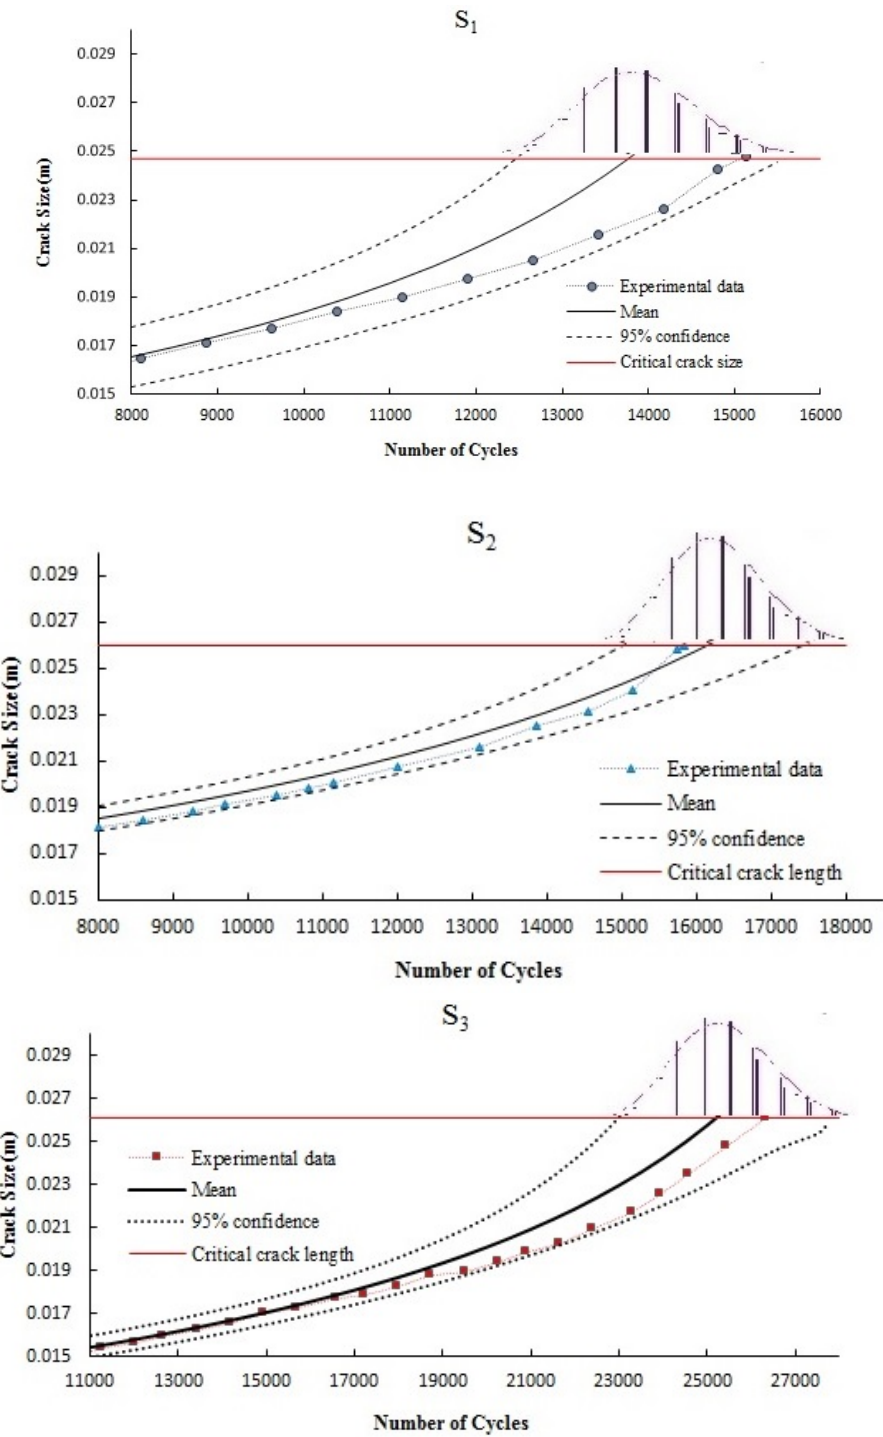
Figure 5. Fatigue crack growth results from Bayesian updating.